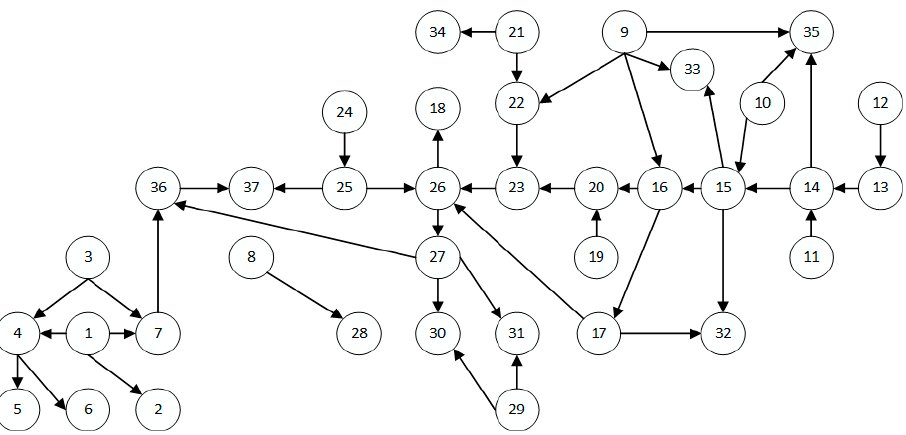
Figure 6. Standard ALARM.